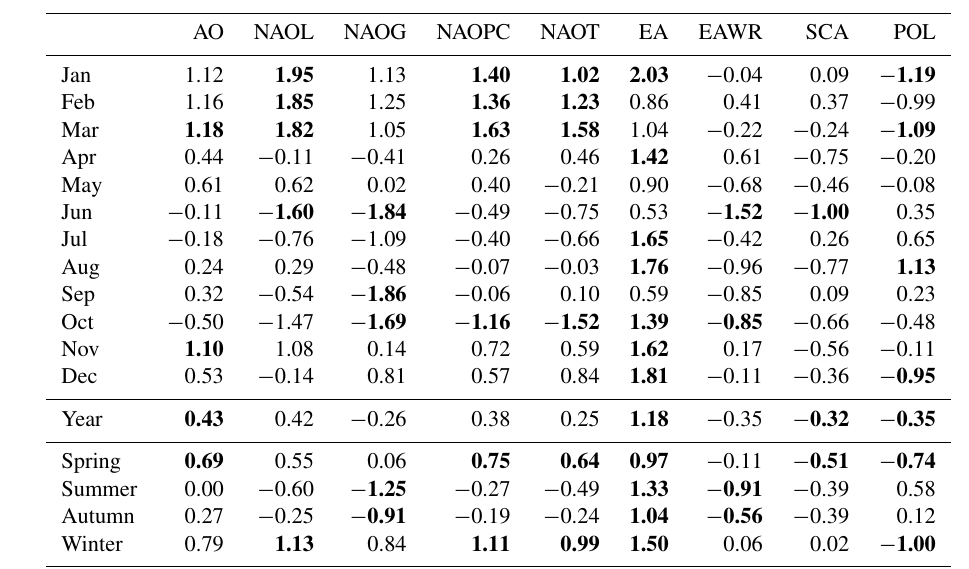
Table 2. Trend values of monthly, annual and seasonal indices of large-scale atmospheric circulation. Statistically significant trends on p <0.05 are in bold.